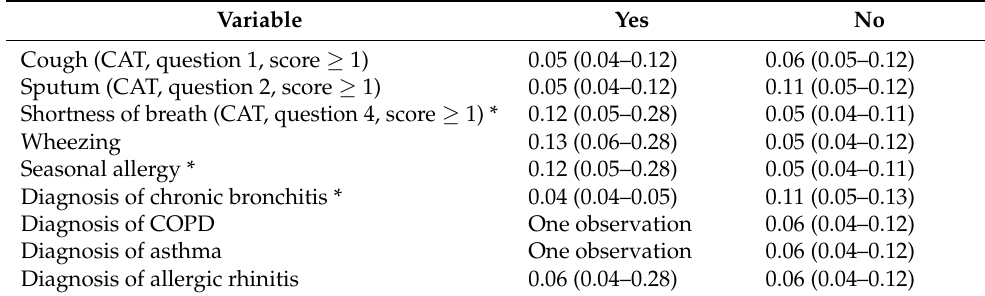
Table 3. Univariate comparisons of indoor median respirable PM concentrations (shown as mg/m 3 ) for selected symptoms from the CAT questionnaire and